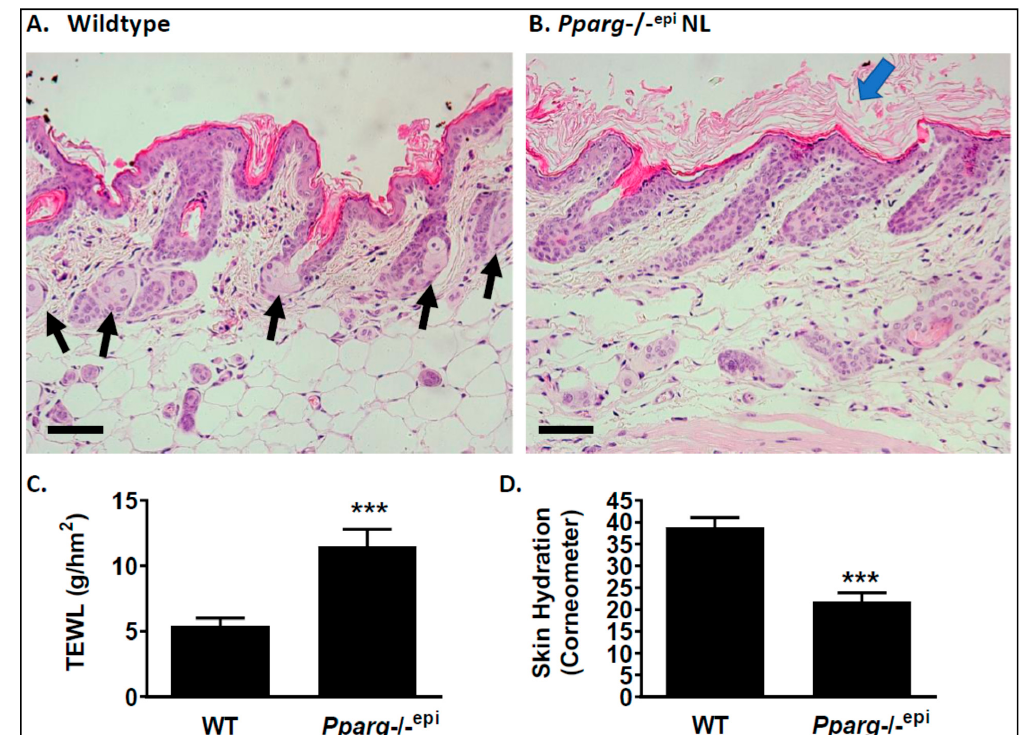
Figure 5. Loss of epidermal Pparg results in an asebia phenotype with hyperkeratosis. ( A ) Representative photomicrograph of a hematoxylin & eosin (H&E) stained slide of skin from a sibling wildtype control mouse. Sebaceous glands are noted by the black arrows. Scale bar = 50 µm. ( B ) Representative photomicrograph of a H&E-stained slide of skin from a Pparg -/- epi mouse (SKH1 background). As in C57. Pparg -/- epi mouse epidermis (Figure 3A), hyperkeratosis was observed (blue arrow). However, the absence of visible sebaceous glands was again apparent (see also Figure 3A). Scale bar = 50 µm. ( C ) Transepidermal water loss (TEWL) is increased in Pparg -/- epi relative to wildtype sibling controls. ( D ) Skin hydration is reduced in Pparg -/- epi relative to wildtype sibling controls. ***, p < 0.001, 2-tailed t -test.